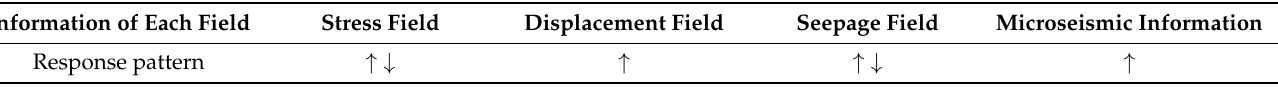
Table 3. Matching mode of the characteristic information of the precursors of the multiple fields. Information of Each